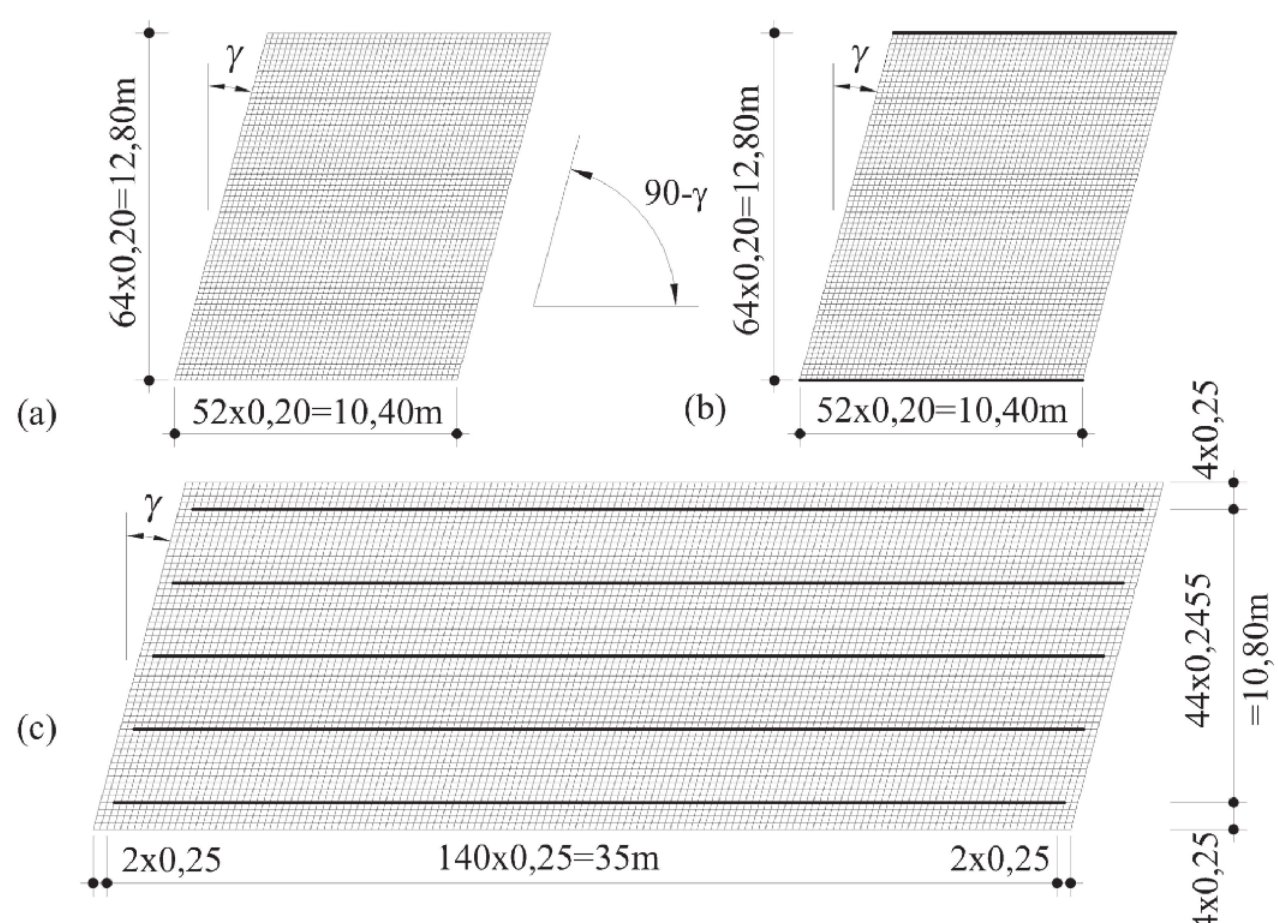
Finite element models for (a) flat bridges without lateral beams, (b) flat bridges with lateral beams, and (c) multi-girder